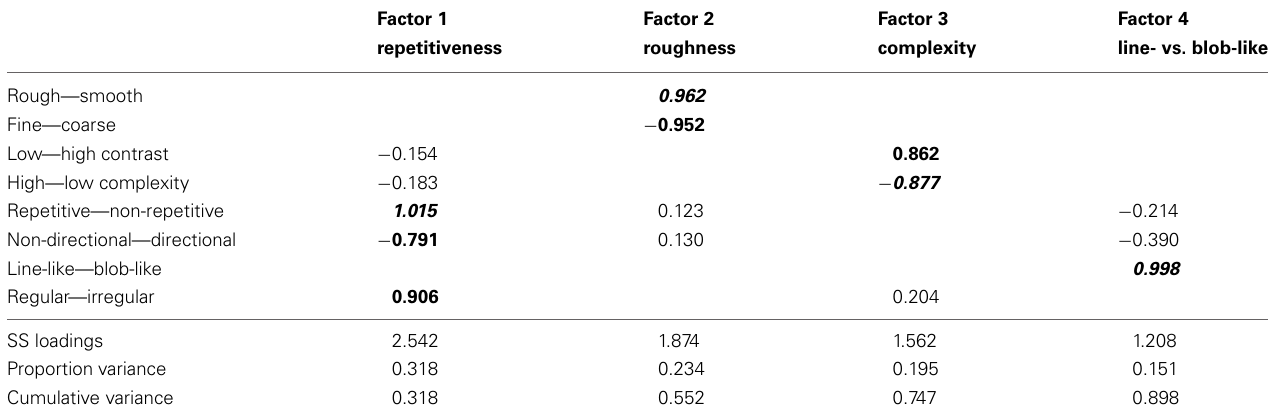
Top: rotated factor loadings of the semantic differentials for four factors. Bottom: sums of squares (SS) loadings of the above factor loadings and the proportionaland cumulative variance of the data that they account for. Bold typeface indicates a strong regression coefficient of the semantic differential with a factor. The semantic differential with the strongest regression coefficient, chosen as representative of a factor, is indicated in